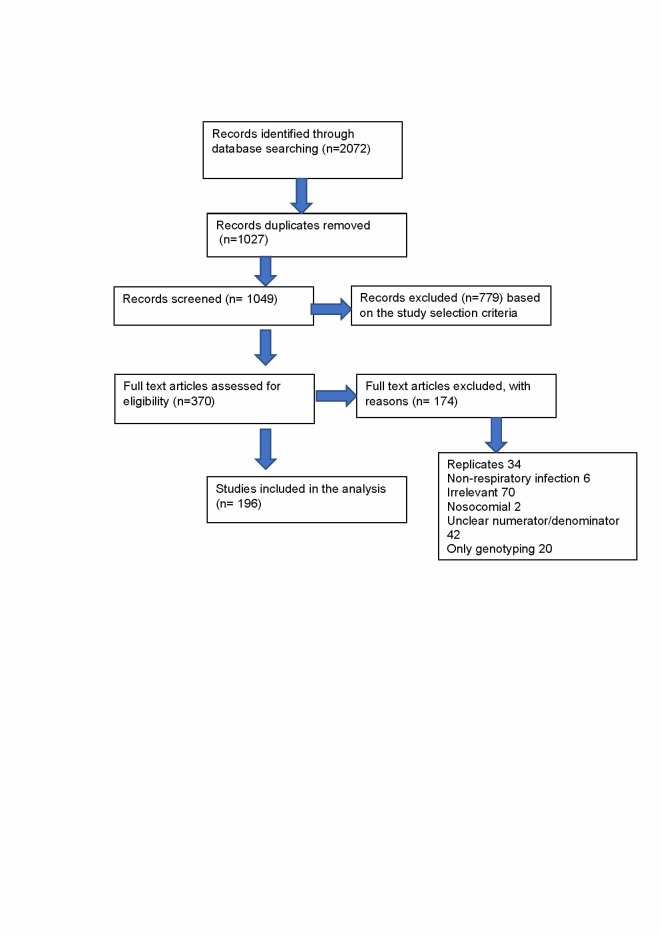
Flow diagram of studies selection. The criteria for identification of irrelevant studies adapted from previous publication [17]): (1) did not discuss respiratory tract infections or respiratory syncytial virus (RSV), (2) RSV mentioned only as background to discussion.